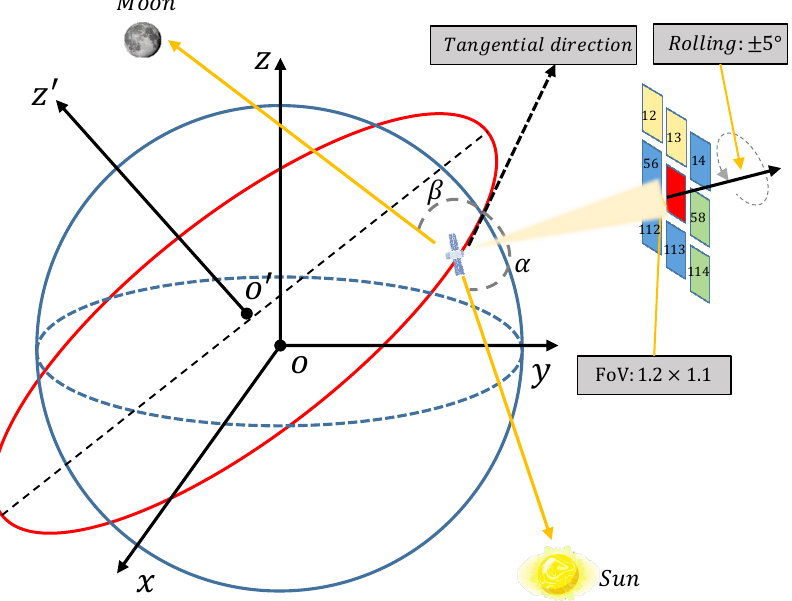
Figure 1. Diagram of the sky survey mission planning. The survey telescope needs to satisfy certain observing constraints during on-orbit observations, such as the angle constraints between the sunlight ( α ), lunar light ( β ), and the observation pointing, etc., shown in the figure. Different colors in the sky zone represent different levels of importance (degree of value) of the observed sky zone. For example, there are extremely deep sky zones, seamless spectral sky zones, etc. The telescope can only be rotated parallel to the orbital plane normal ( Z (cid:48) axis) during the search for the observing sky area. The red square is the area currently under observation. The telescope can only observe one sky area at a time and needs to keep observing for a fixed period of time to complete a single